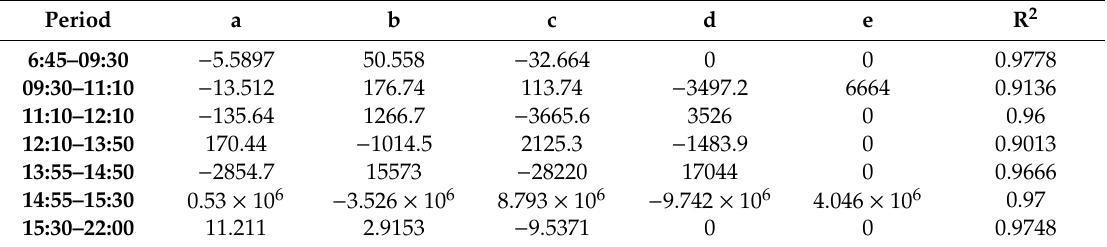
Table 3. Interpolation formulas coefficients for Wed, February 18th, 2015: E [W/m 2 ] = a + bt + ct 2 + dt 3 + et 4 , t ϵ [0,1].